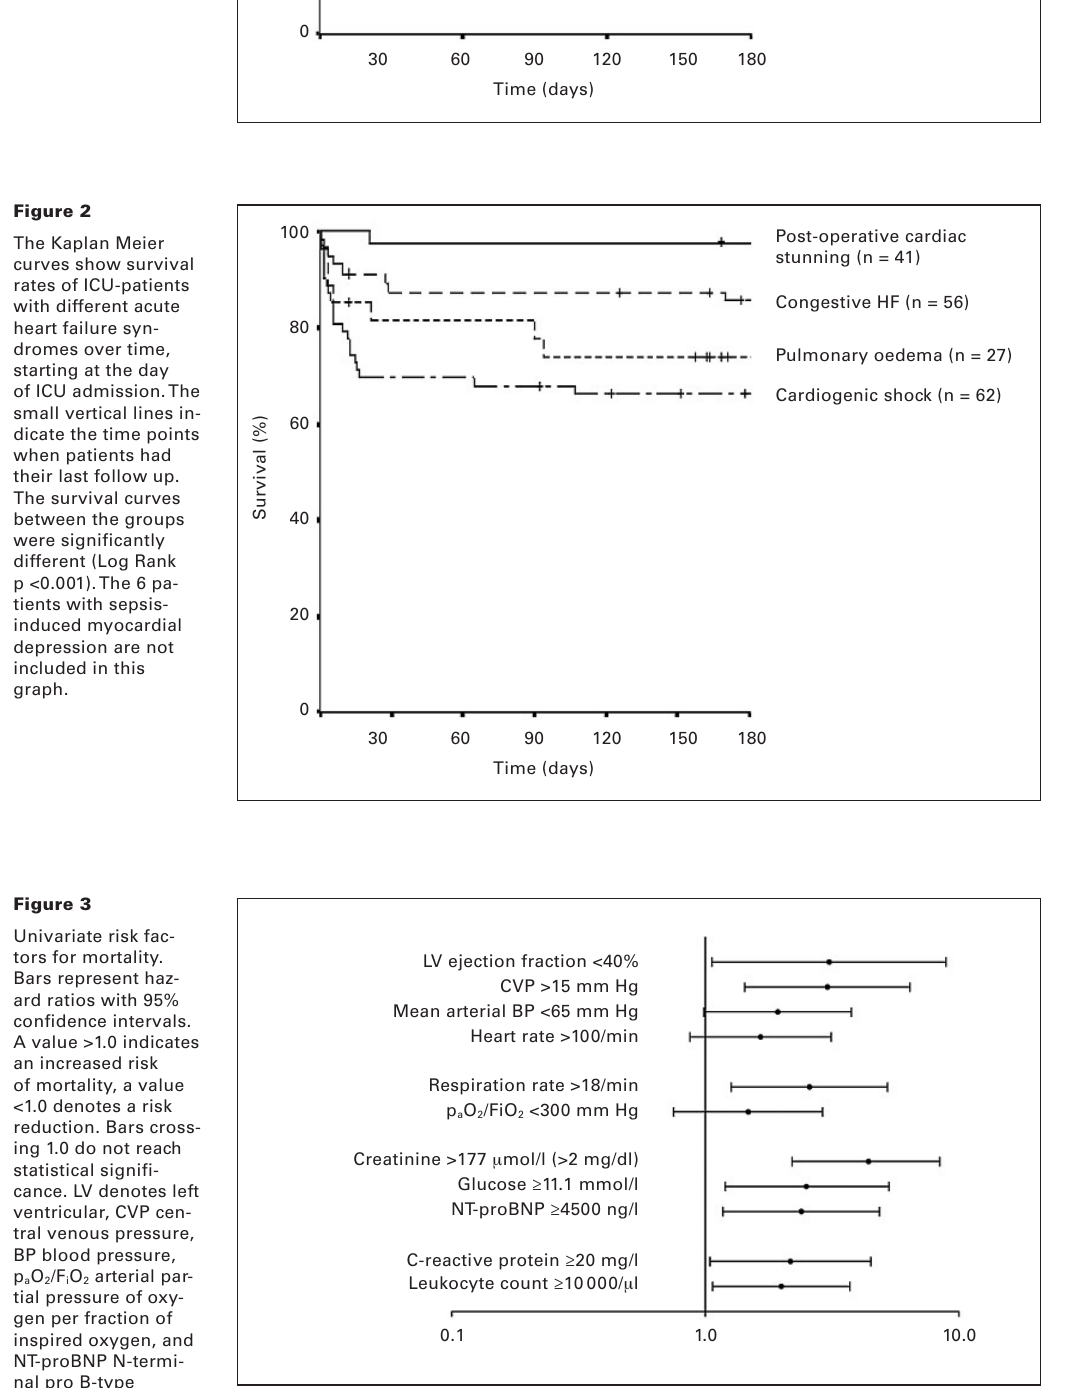
Figure 1 The Kaplan Meier curves show survival rates for three groups of ICU-patients with acute heart failure over time, starting at the day of ICU admis- sion.The small verti- cal lines indicate the time points when patients had their last follow up.The survival curves between the three groups were signifi- cantly different (Log Rank p <0.001).